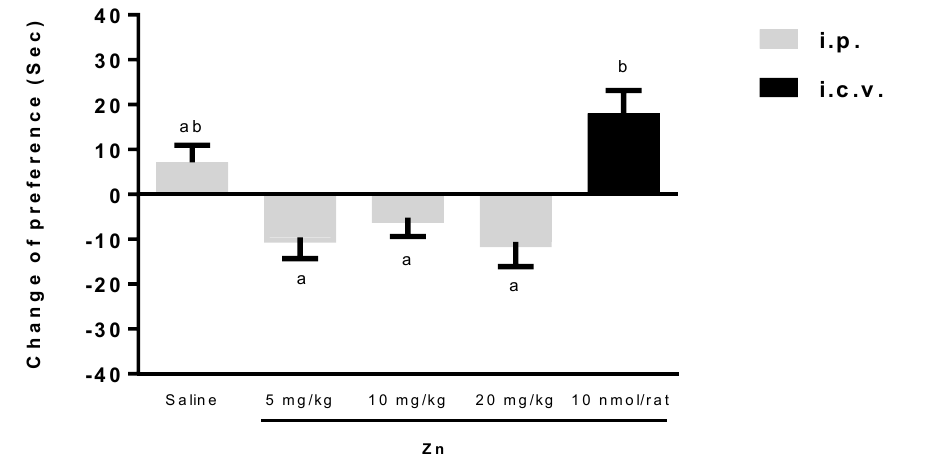
Figure 1. Effects of Zn without morphine on the acquisition (development) of CPP. Zn was given i.p. (5, 10 and 20 mg/kg) and i.c.v. (10 nmol/ rat) separately in the conditioning sections in least preferred compartments. Each point represents the mean± SEM of six rats. Different letters indicate significant differences between groups (p<0.05) (Tukey’s post-hoc test). Zn=Zinc.